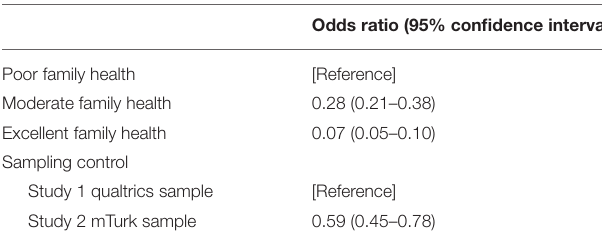
TABLE 7 | Odds ratios for moderate-to-severe depression based on level of family